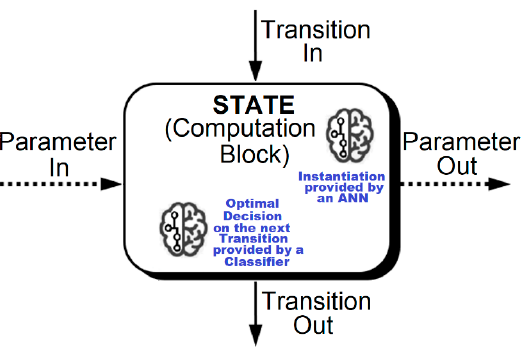
Figure B1. Introducing AI in the basic building block of the smart devices’ FSM (finite state machine) model.